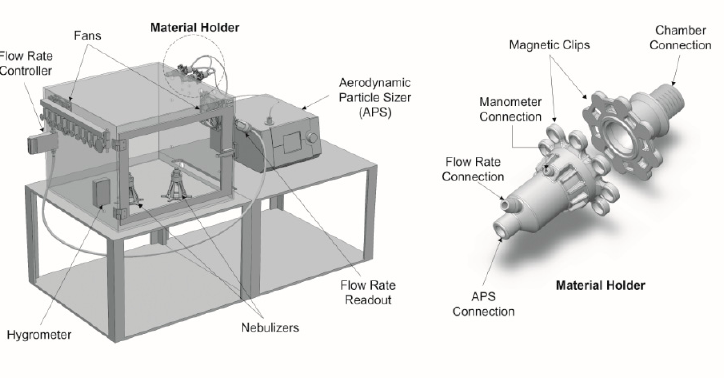
Figure 2. 3D render of the experimental setup. A custom-built aerosol chamber ( left ) contains two mixing fans, two nebulizers, and a hygrometer. Nebulizers generate polydisperse NaCl aerosols and control the humidity within the chamber. Attached to the chamber are two sample holders ( right ), one containing a material insert and one left empty to be used as a reference. The containers are connected to a mass flow rate controller and a manometer to measure the pressure drop. The flow passes through the material holders (one at a time) to the APS for data collection.